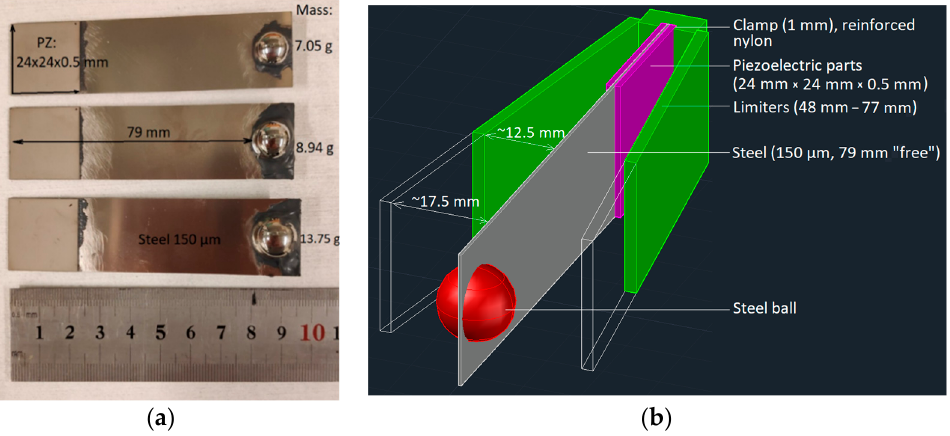
Figure 1. Piezoelectric bimorph type cantilever energy harvester prototype ( a ) dimensions and ( b ) a schematic of an energy harvester.